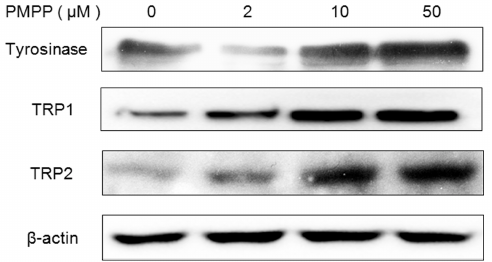
Figure 4. Comparison of Tyrosinase and TRP protein expressions by PMPP. B16 cells were treated with PMPP at 0, 2, 10, and 50 μ M for 48 h. Tyrosinase, TRP-1, and TRP-2 protein expressions were detected by Western blotting. The results were normalized against β -actin expression.